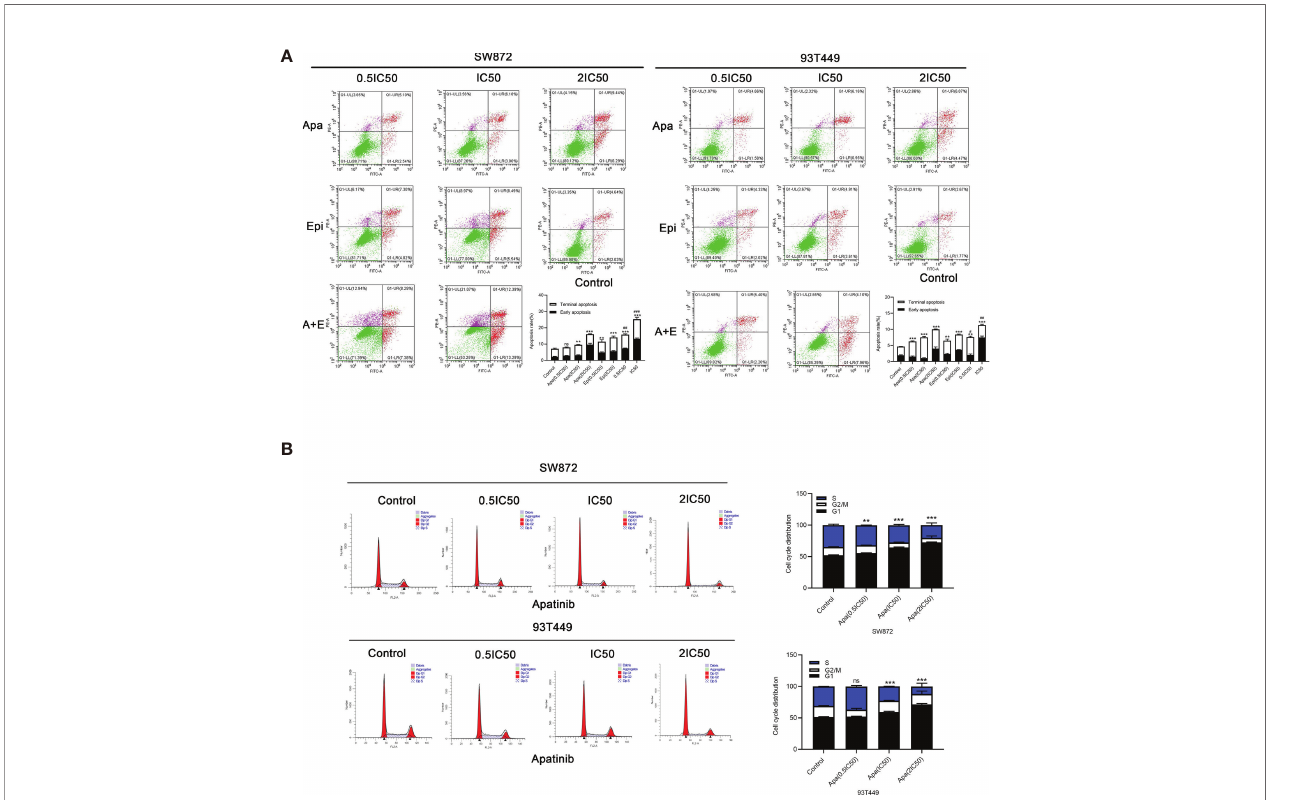
FIGURE 4 | Effects of Apatinib and its combination with Epirubicin on apoptosis and cell cycle of liposarcoma cells. (A) Apatinib increased the rate of apoptosis, and the combination of Apatinib and Epirubicin synergically induced apoptosis. (B) Apatinib induced G0/G1 phase cell arrest in liposarcoma cells. **/*** for comparison between each treatment group and control group, **P < 0.01, ***P < 0.001; # / ## / ### for comparison between Apatinib group and combination group, # P < 0.05, ## P < 0.01, ### P < 0.001; ns: non-signi fi cant; Apa, Apatinib; Epi, Epirubicin; A+E, combination of Apa and